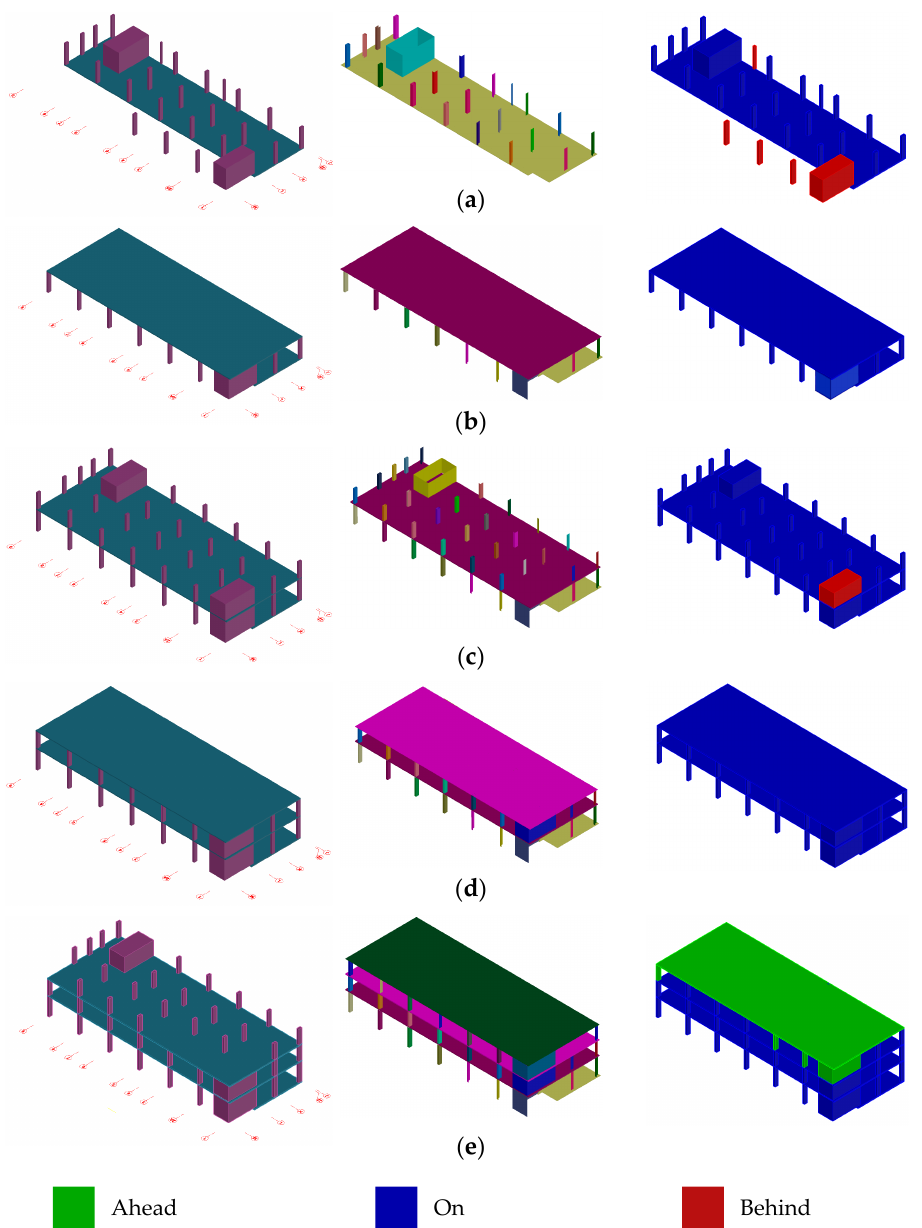
Figure 10. 4D planned model (left), 4D as-built model (middle), and 4D superimposition (right) for